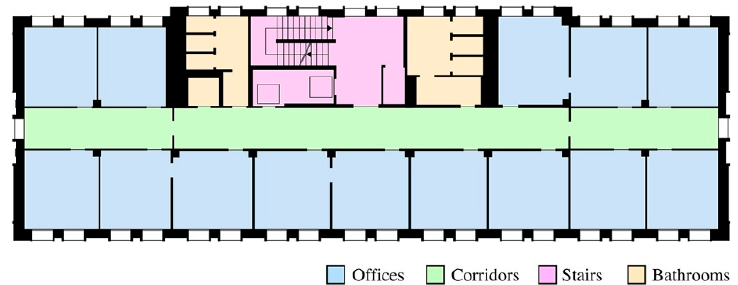
Figure 2. Plan of the analysed storey (5th above-ground floor).